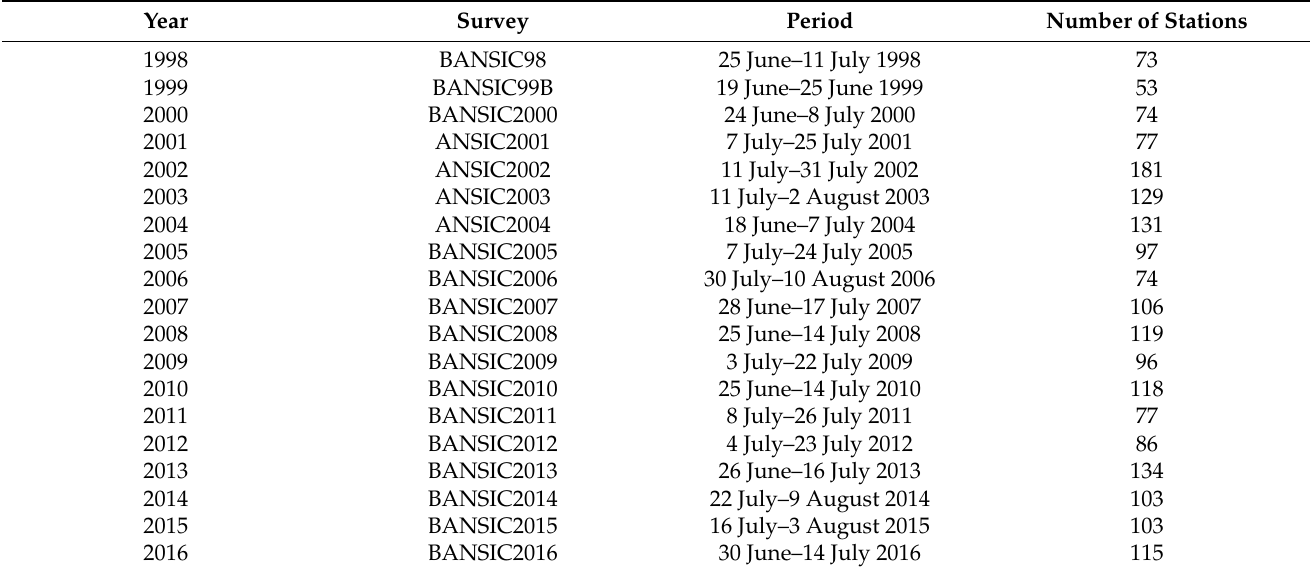
Table 1. List of ichthyoplankton summer surveys in the study area during 1998–2016 with number of stations on the continental shelf (depths < 200